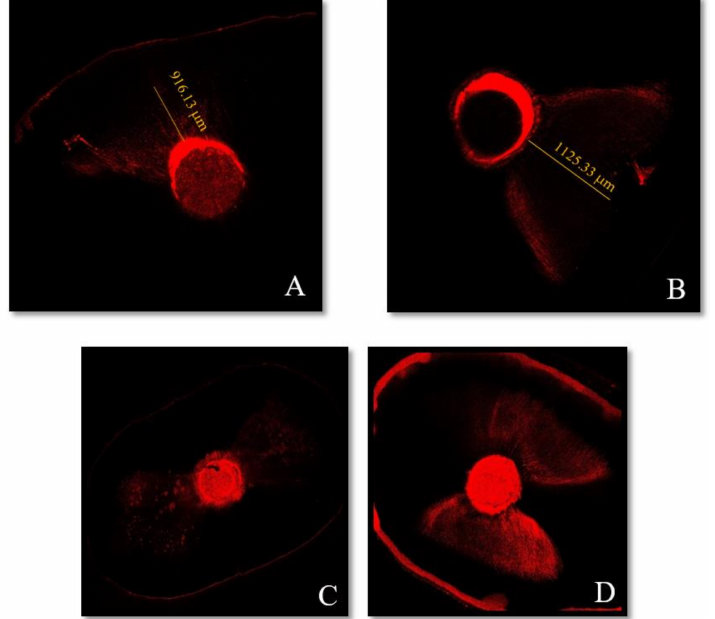
Figure 2. Representative confocal microscopic images of each sealer’s depth penetration in the dentinal tubules at 1 mm from the apex: ( A ) HiFlow sealer with the single cone (SC) technique and ( B ) HiFlow sealer with warm vertical compaction (WVC). Moreover, at 5 mm from the apex: ( C ) HiFlow sealer with the SC and ( D ) HiFlow sealer with